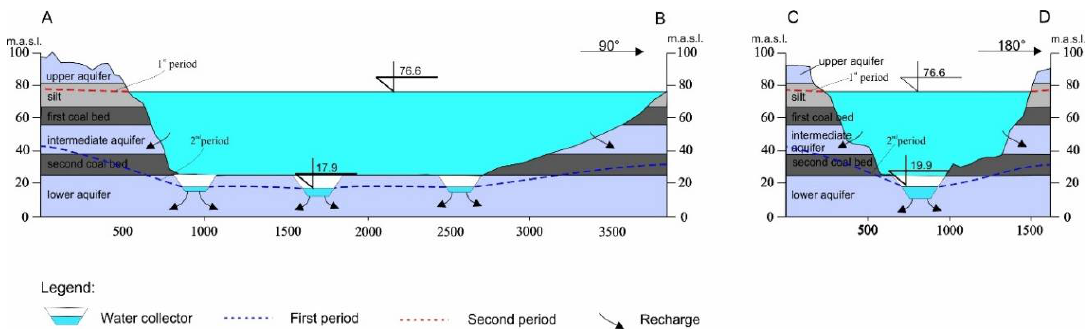
Figure 6. Flood lakes in the western part of the Kolubara Coal Basin after the flood on 14 May 2014– status as on 22 May 2015.